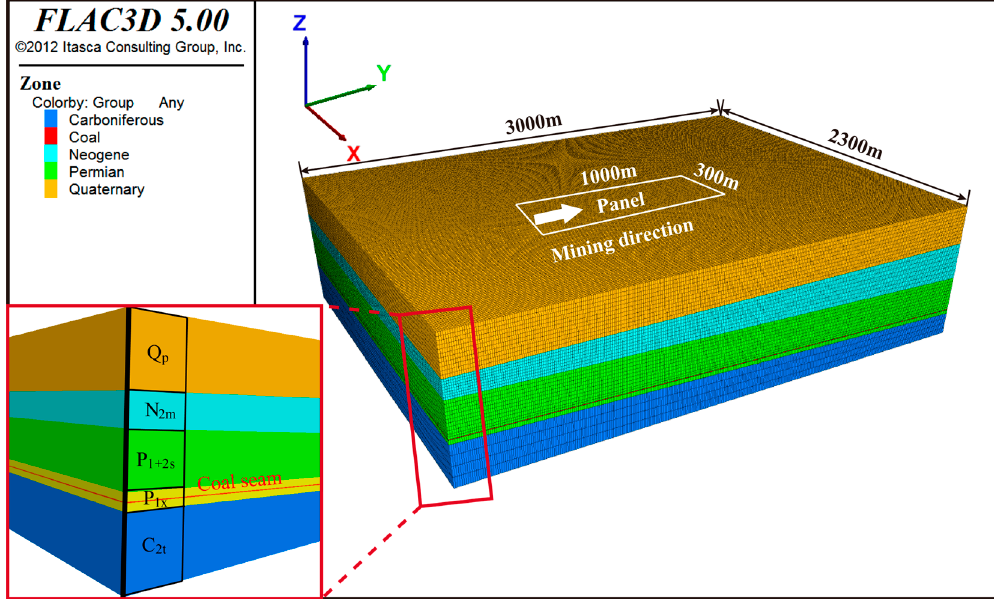
Figure 10. Computational mesh model.